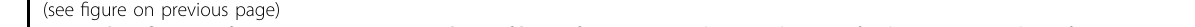
Fig. 2 Identi fi cation of CD44 as a negative regulator of heCIC formation. a Schematic diagram of isolating isogenic clones from PLC/PRF/5 by limited dilution for heCIC assay. b , c HeCIC pro fi ling for the isogenic clones, displayed as heCIC frequency ( b ), average number of internalized CCRF- CEM cells (the insert graph of b ), and the percentage of heCIC structures with different internalized CCRF-CEM cells ( c ). Data are means ± SD of quanti fi cations from more than two independent investigators. More than three images of 20× objective were quanti fi ed for each isogenic clone. d The representative images of cytospins for isogenic clones of low and high heCIC formation. Scale bars: 100 μ m, and 20 µm, respectively. e The unsupervised clustering of genes differentially expressed between three low-CIC and fi ve high-CIC isogenic clones, and green for low expression, red for high expression. Five probes for CD44 were identi fi ed in the gridded region. f Relative mRNA level of CD44 by mRNA microarray and quantitative real-time PCR (RT-PCR) in PLC/PRF/5 isogenic clones. g HeCIC formation in isogenic cell clones co-cultured with CCRF-CEM cells. Data are means ± SD of more than three images of 20× objective. n > 300 cells analyzed for each clone. h Relative expression of CD44 upon small interfering RNA (siRNA)- mediated knockdown in F6ft cells. Data are means ± SD of triplicate experiments. i , j Increased formation of heCIC structures in control and CD44- depleted PLC/PRF/5 cells. Cell-in-cell 1 (%) = numbers of PLC/PRF/5 cells in CICs/number of total PLC/PRF/5 cells; Cell-in-cell 2 (%) = numbers of internalized CCRF cells/number of total PLC/PRF/5 cells counted. Data are means ± SD of more than three images of 20× objective. n > 300 cells analyzed for each clone. k – m Overexpression of CD44 ( k ) inhibits heCIC formation ( l , m ) in A4S cells. Data are means ± SD of more than three images of 20× objective. n > 300 cells analyzed for each